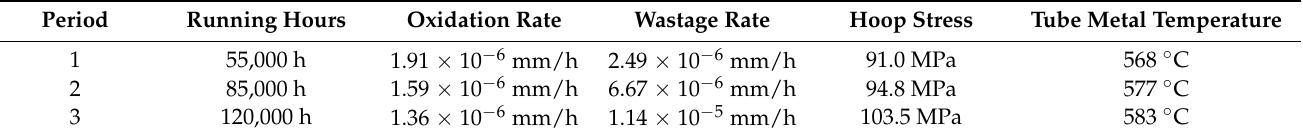
Table 3. Assessed information for the tube.